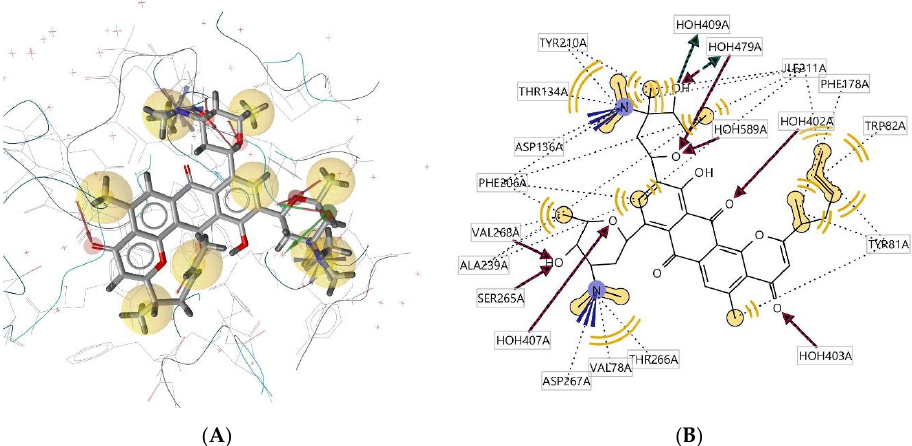
Figure 11. Ligand 298D interacts with the macromolecule. ( A ) 3D view of pharmacophore at the macromolecule binding site. ( B ) 2D view of pharmacophore. Pharmacophore features: hydrophobic interactions (H), yellow; hydrogen bond acceptor (HBA), red; hydrogen bond donor (HBD), green; positive ionisable area (PI) interaction, purple. Ligand 950D interacts with the macromolecule, as shown in Figure 12A,B. It shows